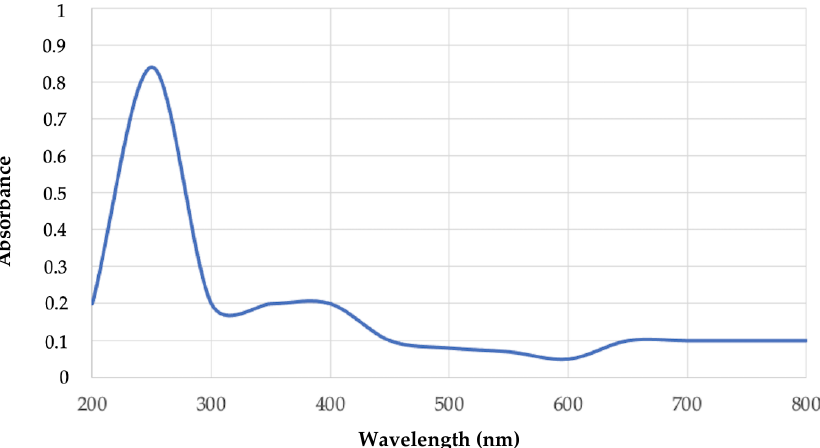
Figure 10. UV-Visible spectrum of putative PHB extracted from strain Figure 10. UV – Visible spectrum of putative PHB extracted from strain 1B .